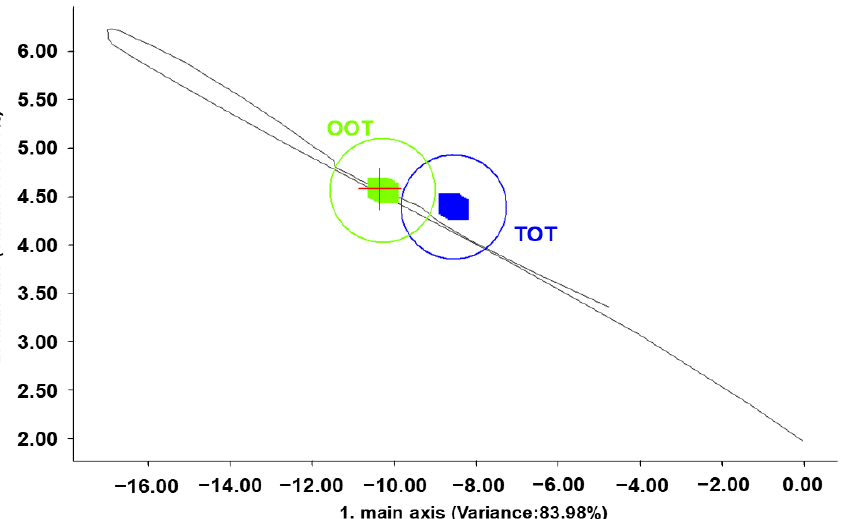
Figure 1. Principle component analysis of aroma-active compounds of TOT and OOT analyzed by an electronic nose.